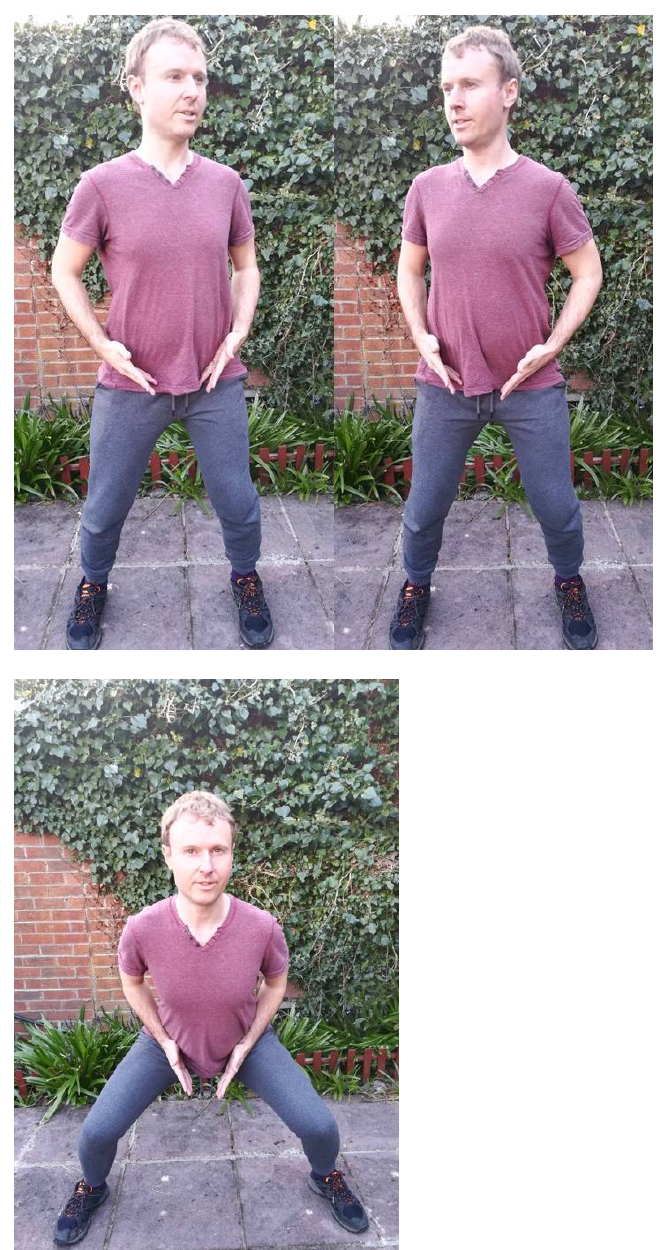
Figure 3. Kua Movements: Left, Right and Down.